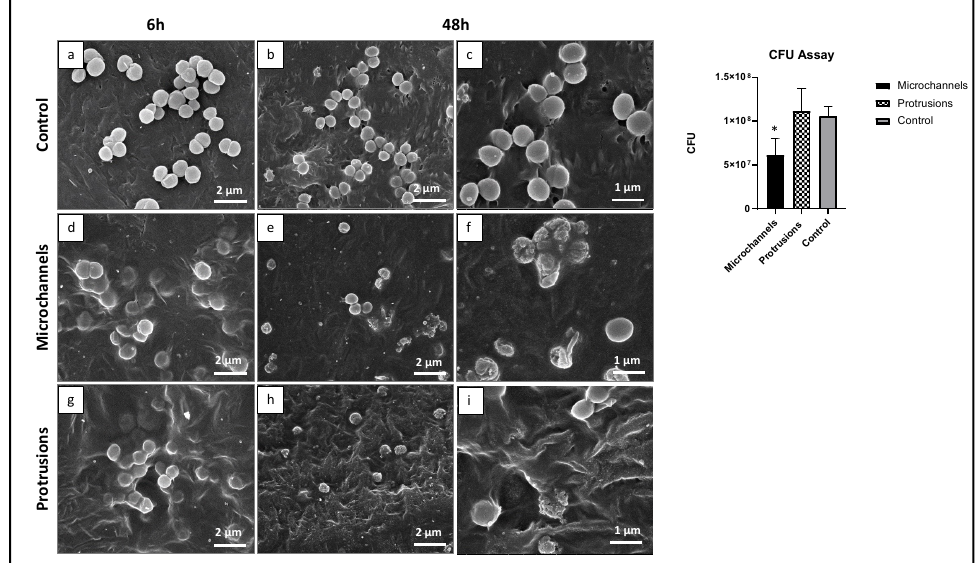
Figure 10. Representative SEM images (6 h and 48 h) of PCL surfaces colonized with S. Aureus — topographies of the control ( a – c ), laser-induced microchannels ( d – f ), and protrusions ( g – i ),. CFU assay on the three PCL surfaces. Scale bar: 2 μ m ( a , b , d , e , g , h ), and 1 μ m ( c , f , i ). * Significant difference from control (unmodified PCL), p ≤ 0.05.